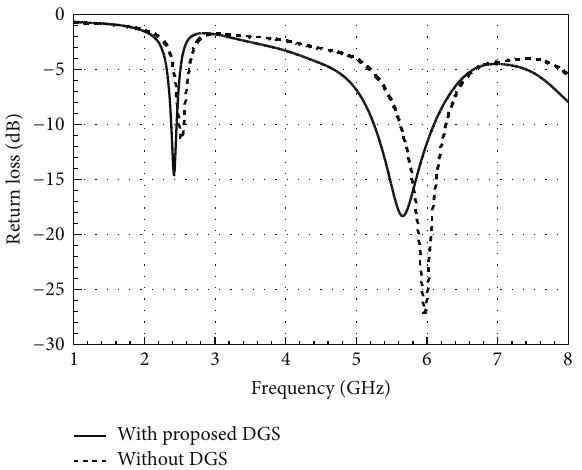
Figure 7: The simulated return losses 𝑆 11 for the proposed PIEA with DGS and without DGS in the ground